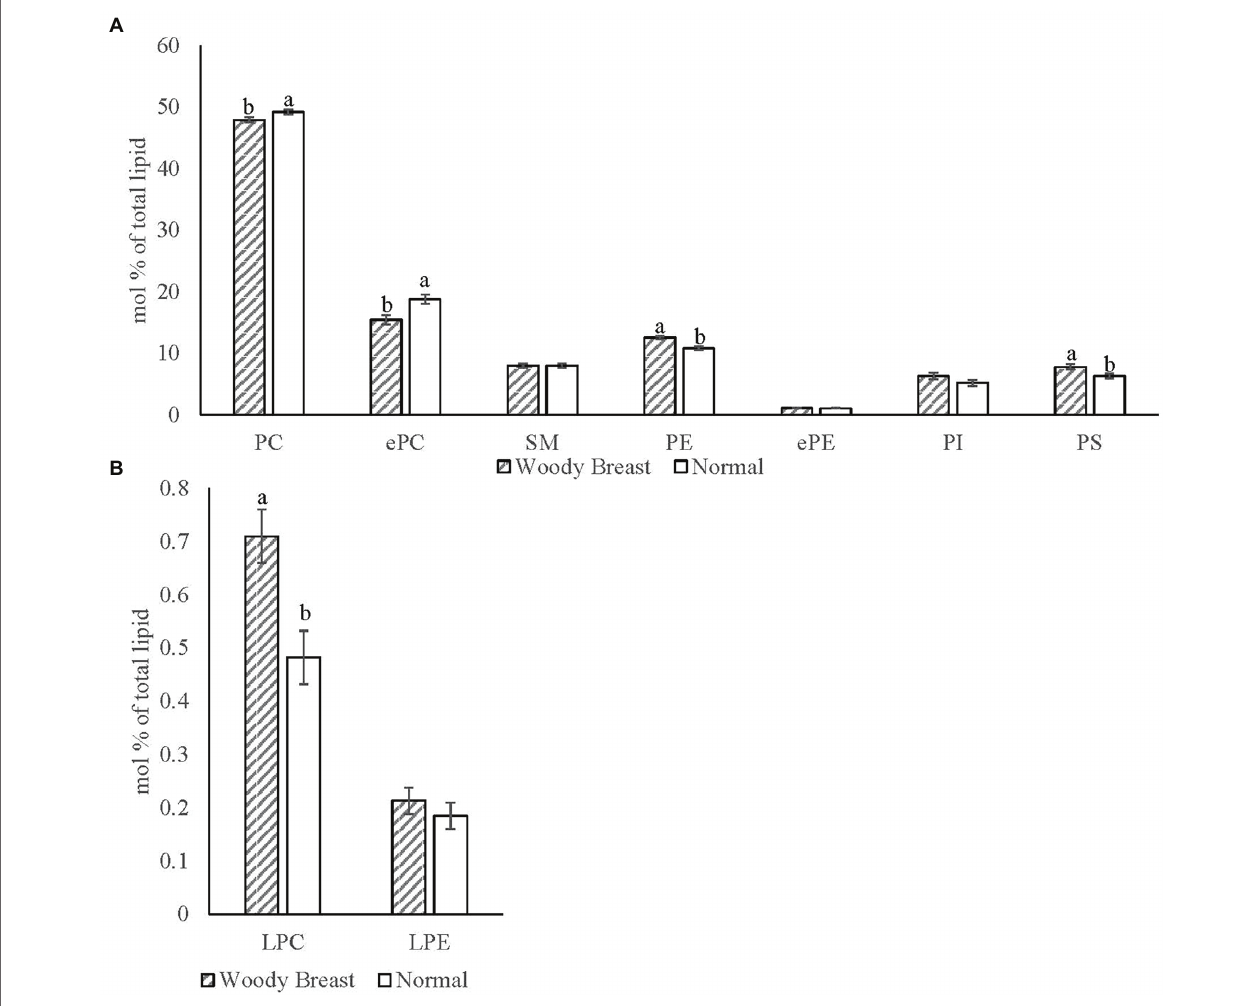
FIGURE 5 | Woody breast syndrome altered sarcoplasmic reticulum (A) phospholipid classes and (B) hydrolysis product mol% [(nmol of phospholipid class/nmol of total phospholipid) x100]. Each bar represents the mean ± standard error and means with different letters within a lipid class are different at p < 0.05. PC, phosphatidylcholine; ePC, ether-linked PC; SM, sphingomyelin; PE, phosphatidylethanolamine; ePE, ether-linked PE; PI, phosphatidylinositol; PS, phosphatidylserine; LPC, lysophosphatidylcholine; LPE,